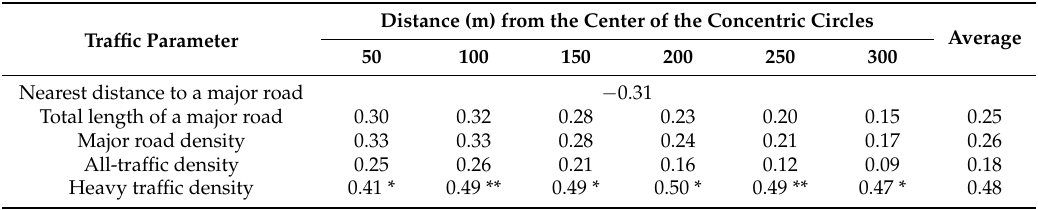
Table 2. Correlation coefficients of traffic-related metrics with measured black carbon